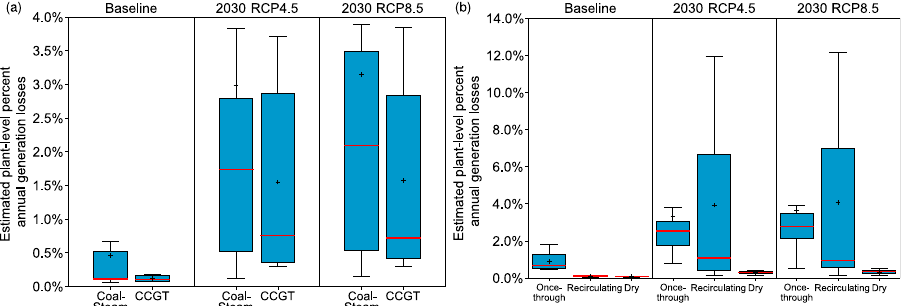
Fig. 6 Plant-level physical climate risk-induced generation losses. a shows the generation losses grouped by generation type; b by cooling technology. The red line inside each box is the median. The black crosses are the mean values. The box shows the 25th (Q1) and 75th (Q3) percentile, and the upper whisker extend to Q3 + 1.5 * (Q3 – Q1) and the lower to Q1 – 1.5 * (Q3 – Q1). The plant counts are in Table 3.